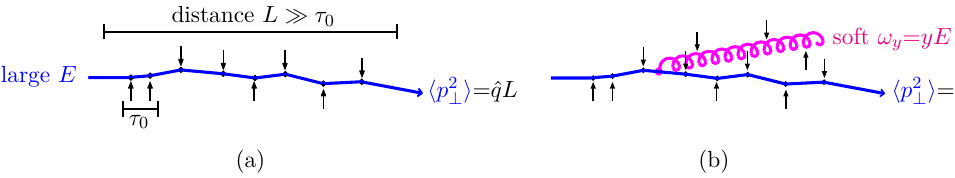
Figure 1 . (a) A cartoon of transverse momentum broadening as a high-energy particle traverses a QCD medium. The arrows represent small transverse momentum kicks from the medium due to small-angle elastic scattering with the medium. (b) The same, but here some transverse momentum is also carried away by a relatively soft (but still high-energy) bremsstrahlung.